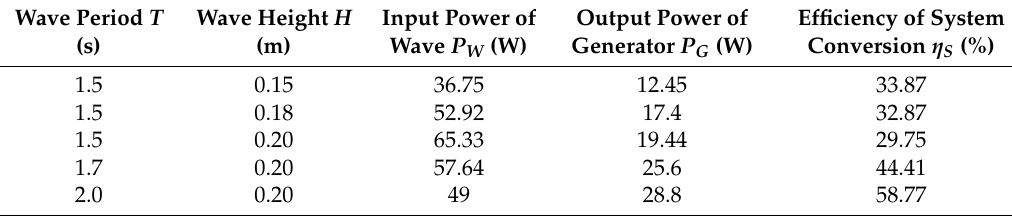
Figure 16. Output voltage waveform of the D-DWEC system. ( a ) (1 s/div, 10.0 V/div), ( b ) (1 s/div, 10.0 V/div), ( c ) (0.2 s/div, 10.0 V/div), and ( d ) (0.2 s/div, 10.0 V/div). Table 3. System conversion